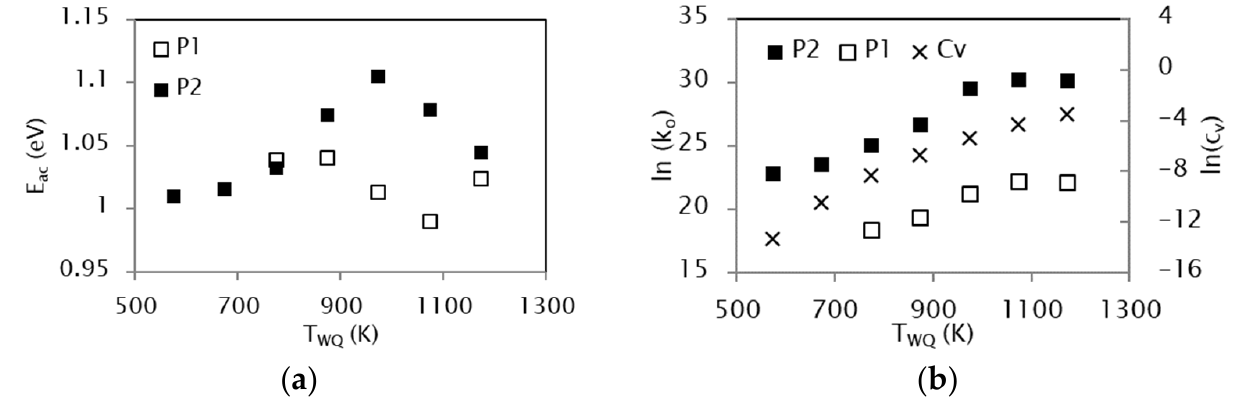
Figure 9. Activation energies ( a ) and pre-exponential factors ( b ) as a function of T WQ obtained after Equation (10) using n = 1 from the lines in Figure 8.